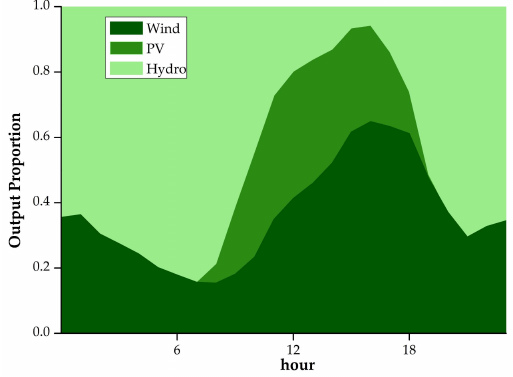
Figure 7. Dispatch scheme of S-SP.